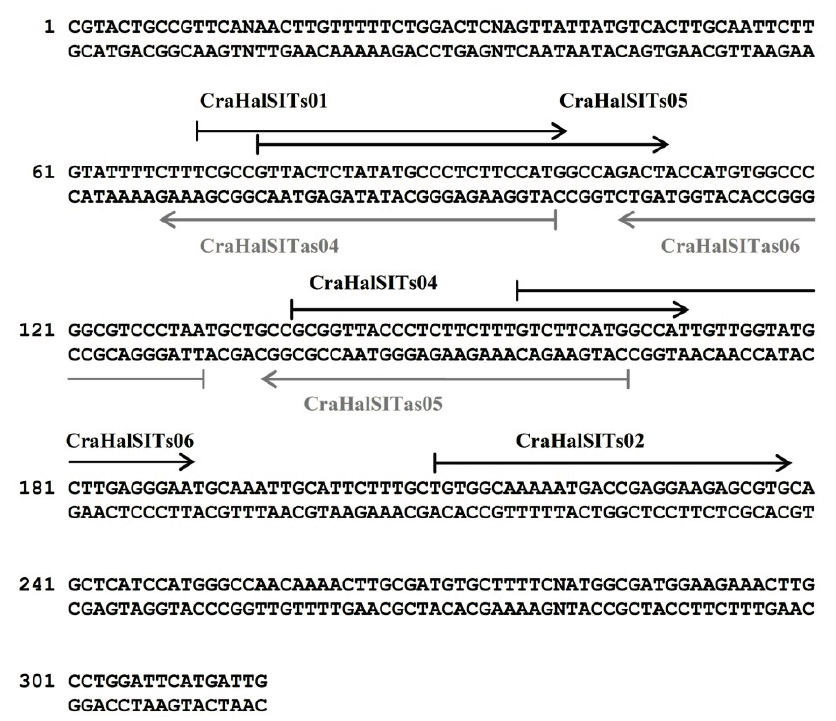
Figure 4. Details of oligonucleotide probes designed on the amplicon corresponding to a portion of SIT gene of Craticula halophila . Black and grey arrows indicate sense probes and antisense probes,